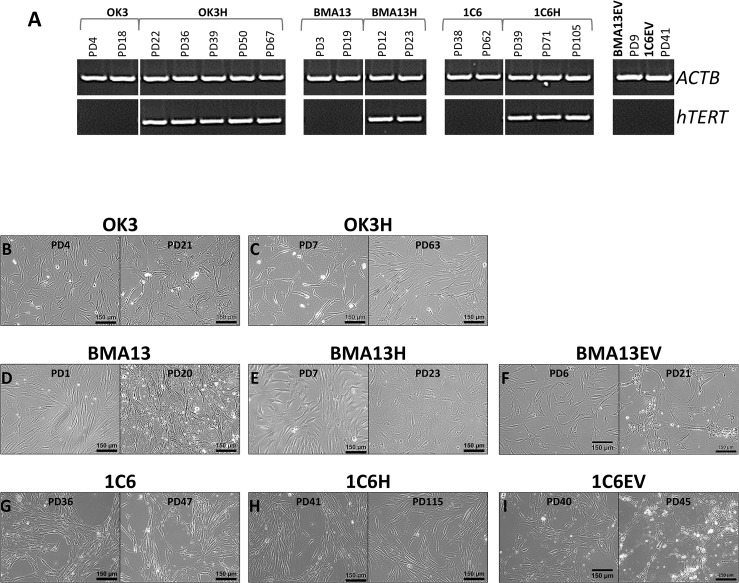

hTERT expression and impact on cell morphology.(A) Expression of the housekeeping gene ACTB and hTERT determined by RT-PCR in cells following recovery post transduction and with expansion in continuous cell culture. (B-I) Phase contrast micrographs of cells in monolayer culture pre- (B, D and F) and post- (C, E and G) transduction with hTERT or with empty vector (F and I) Scale = 150 μm, exact PD as indicated in image.